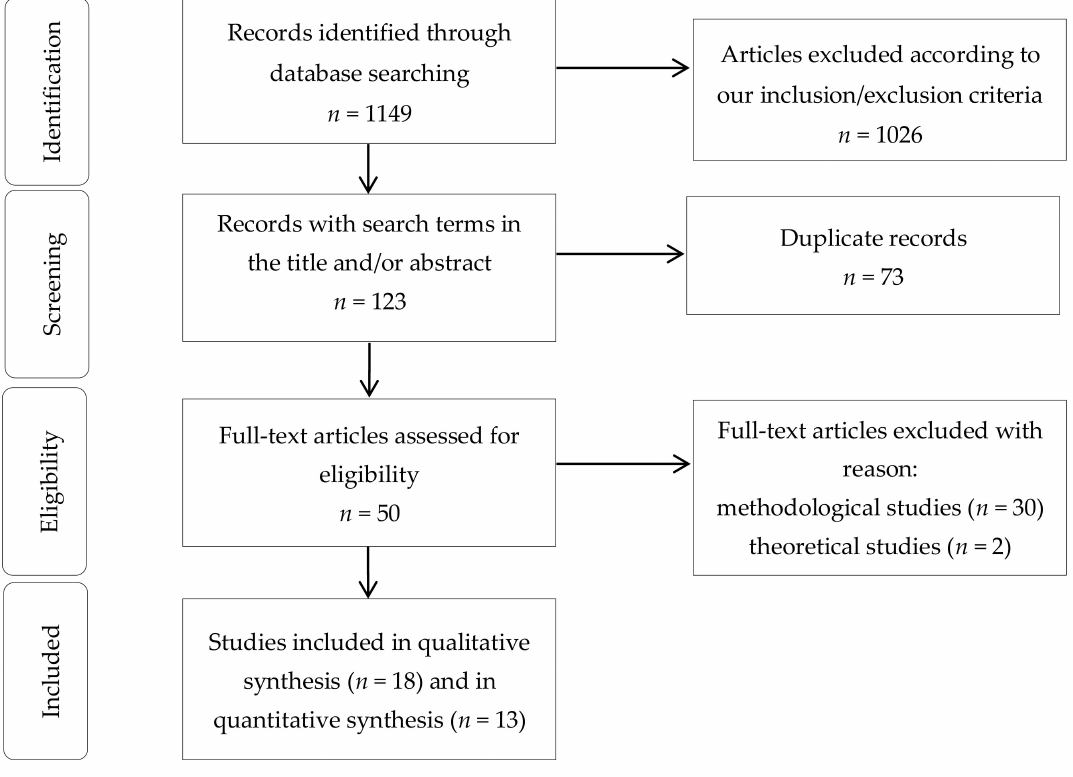
Figure 1. Article selection